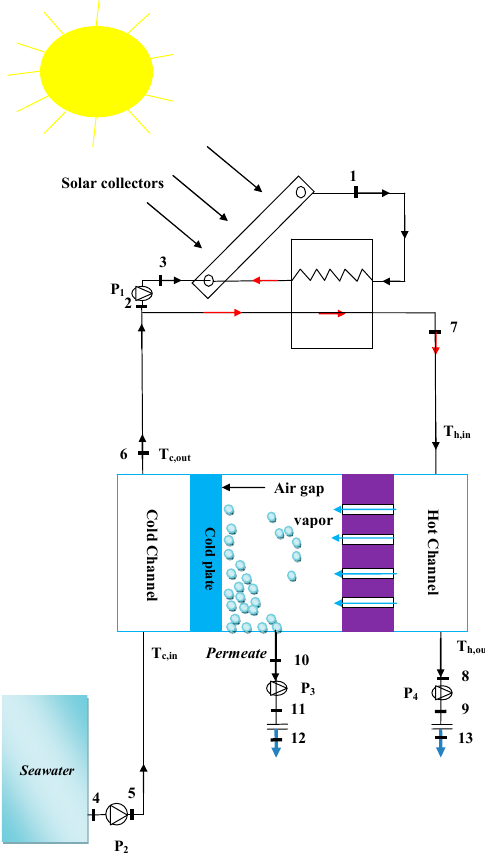
Figure 1. Schematic diagram of the AGMD process.